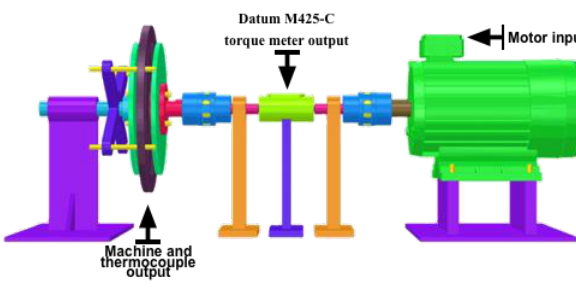
Figure 6. 3D design of the test bench.